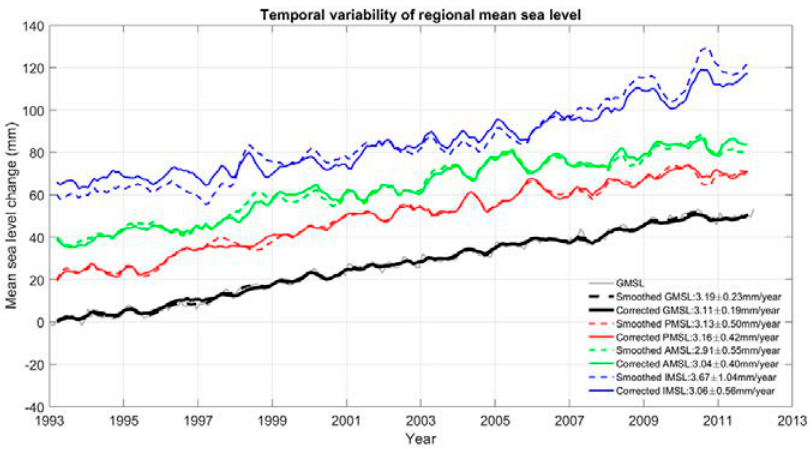
Fig. 7. – Time-series of temporal mean sea level change derived from AVISO data from 1993 to 2012 in the global averaged oceans (GMSL, black), Pacific Ocean (PMSL, red), Atlantic Ocean (AMSL, green) and Indian Ocean (IMSL,